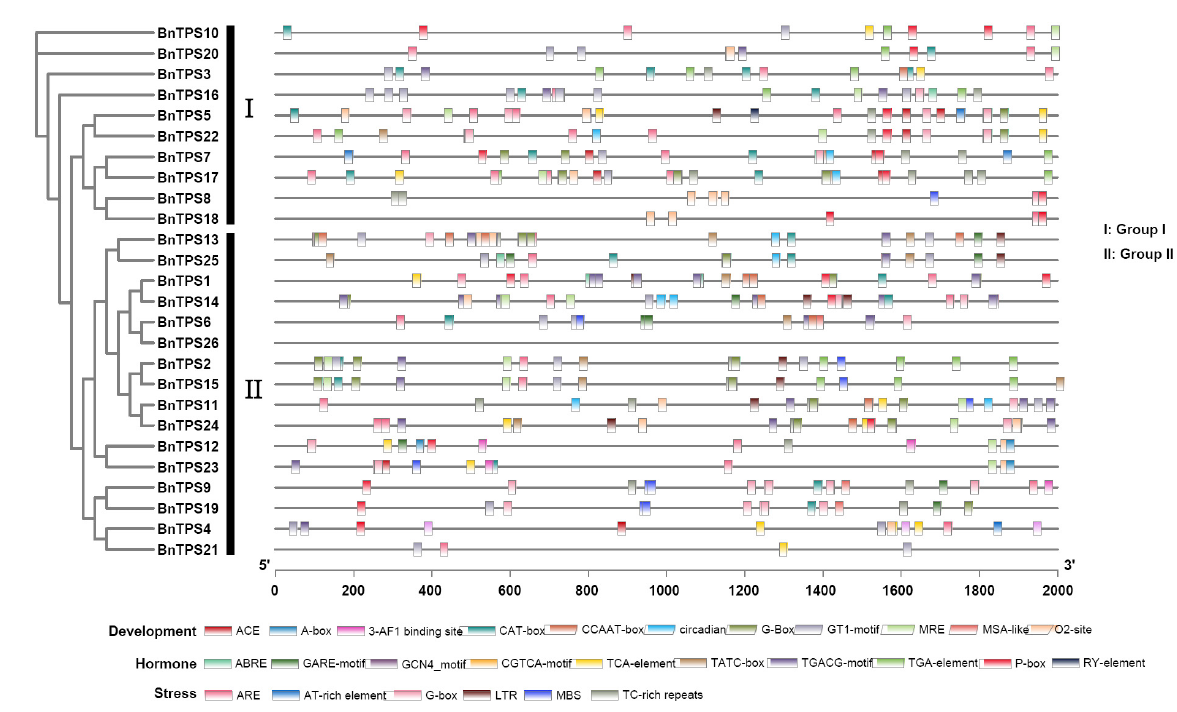
Figure 4. Cis -acting regulatory elements identified in the BnTPS genes promoter regions . Different colors represent various elements.